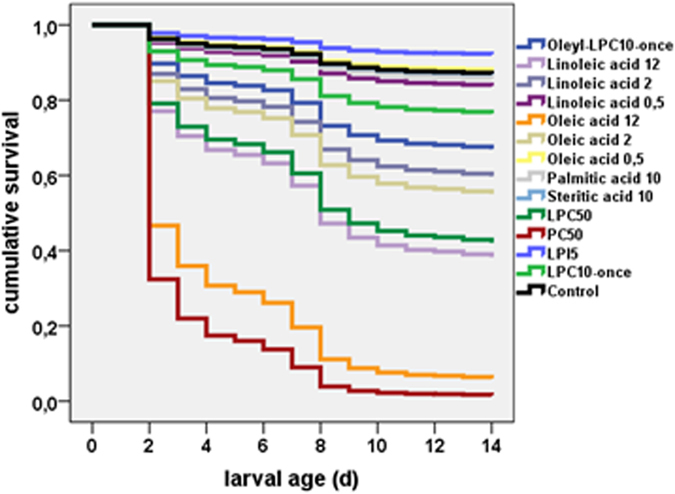
Cumulative survival rate of honeybee larvae fed with different doses (µg/larvae/d) of test compounds on day 1.The observation period was 14 d. Replicates: oleoyl-LPC (48/48/48), linoleic acid 12 (48), 2 (48/48) and 0.5 (48/48), oleic acid 12 (48), 2 (48/48) and 0.5 (48/48), palmitic acid (48/48), stearic acid (48/48), LPC 50 (48), PC (48), LPI 5 (48/48), LPC 10 (48/48/48), control (48/48/48/48/48/48/48/48).